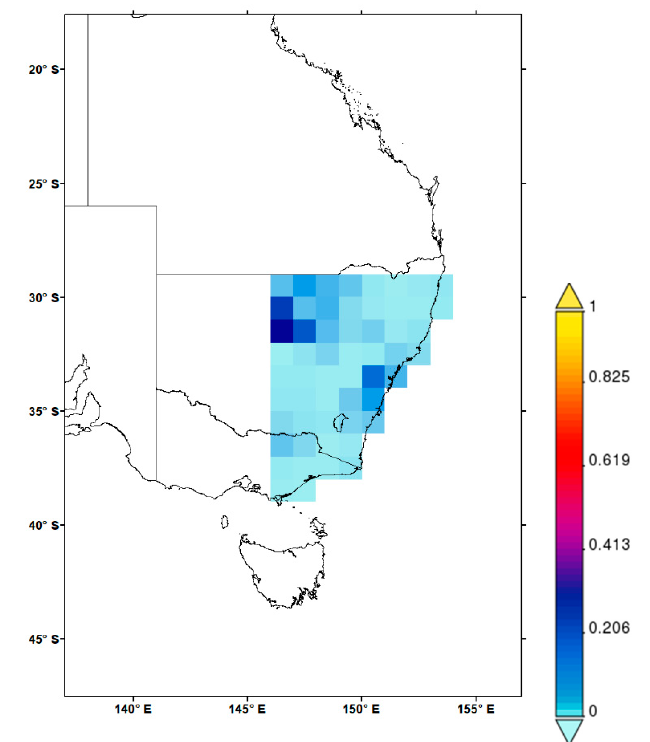
Figure 17. Time averaged map of AOD 550 nm (deep blue, land-only) daily 1° (MODIS-Aqua MYD08_D3 v6.1) for the period 4–7 May 2016.